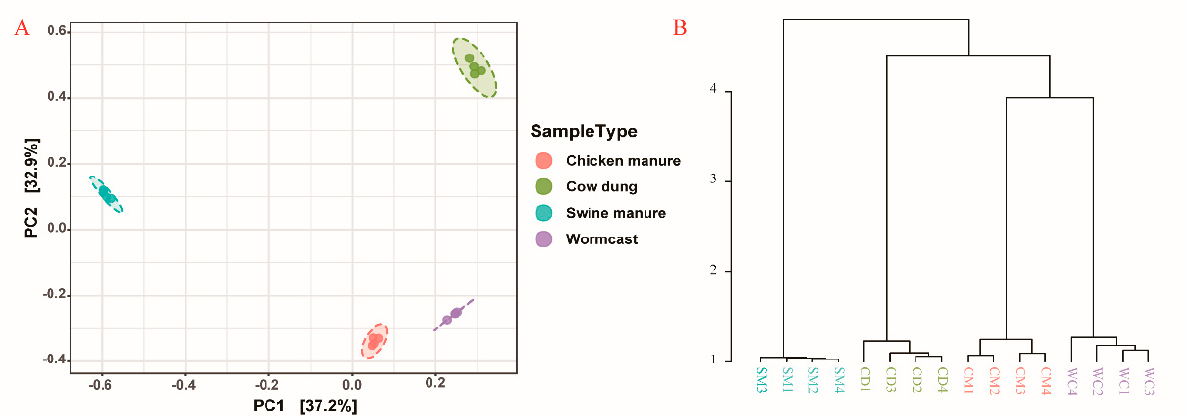
Figure 3. Principal coordinate analysis (( A ) PCoA) and hierarchical cluster tree ( B ) of myxobacteria communities (calculated based on Bray_Curtis distances). CM: Chicken manure, CD: Cow dung, SM: Swine manure, and WC: Wormcast.